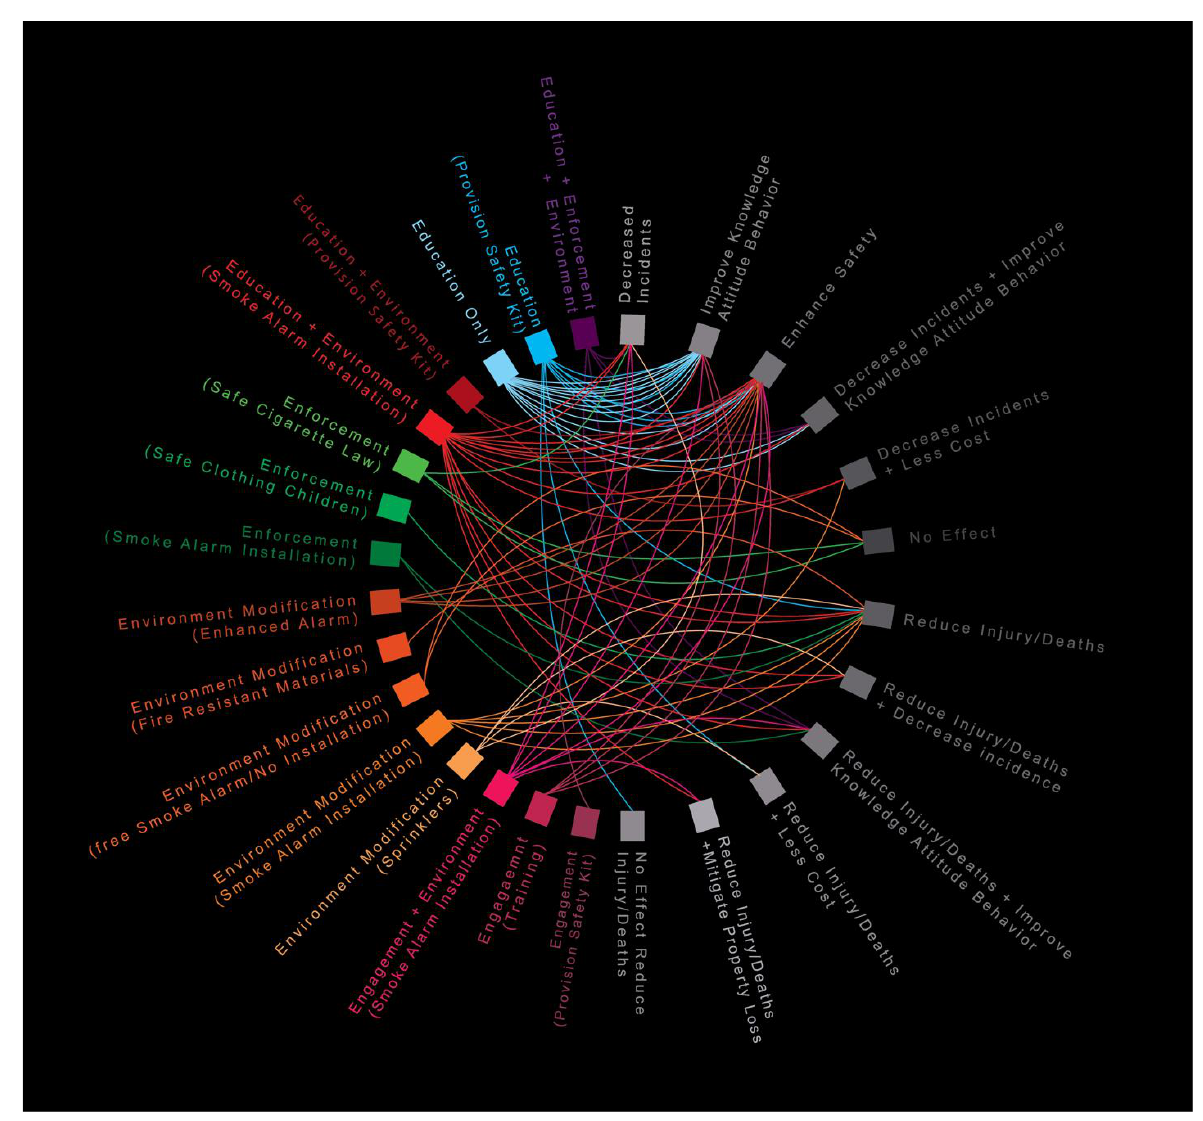
Figure 2. Chord chart links each of the 4E’s interventions with its measured outcome(s) as reported in the included studies.